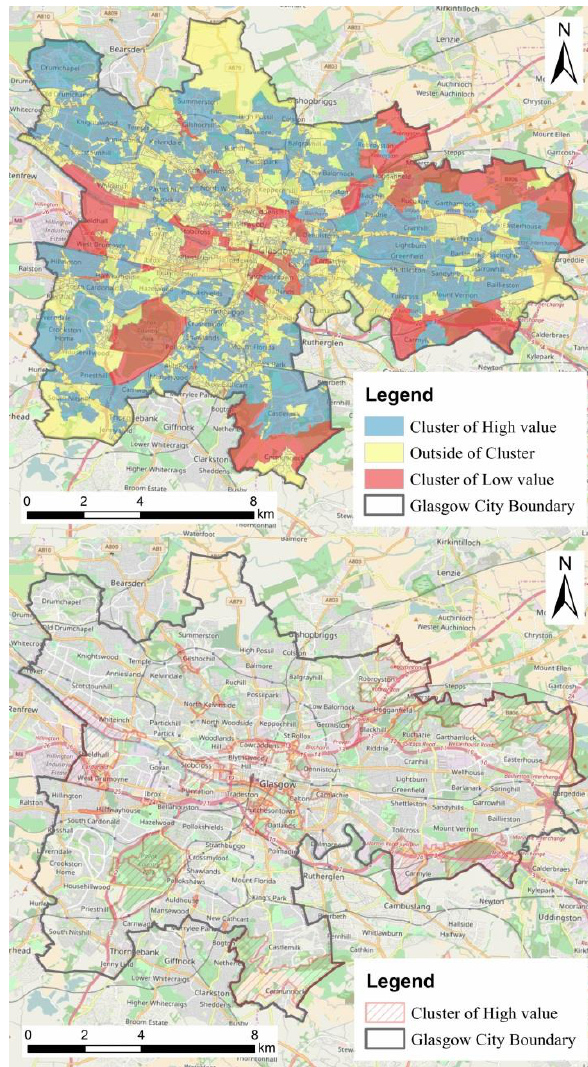
Figure 5. Clusters of high RCADTP (Basemap: OpenStreetMap, licensed under the Open Database